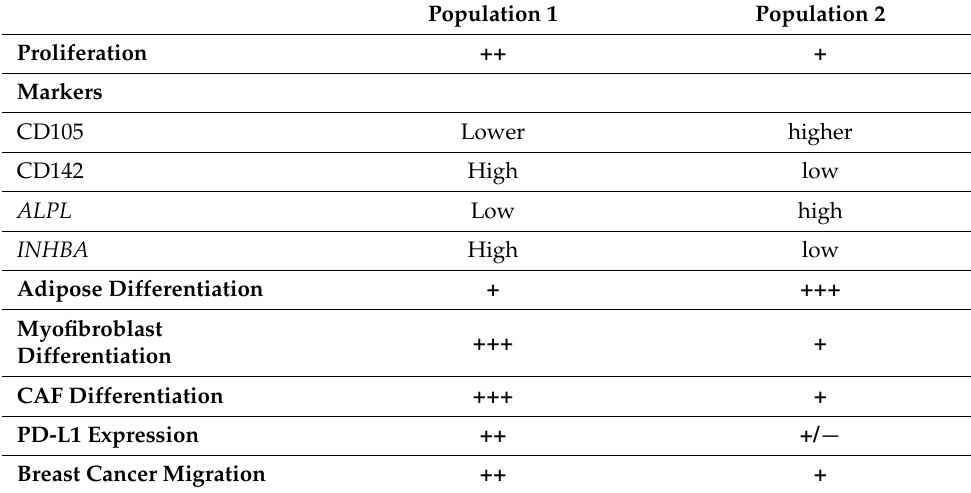
Table 2. Summary of the properties of the two breast APC